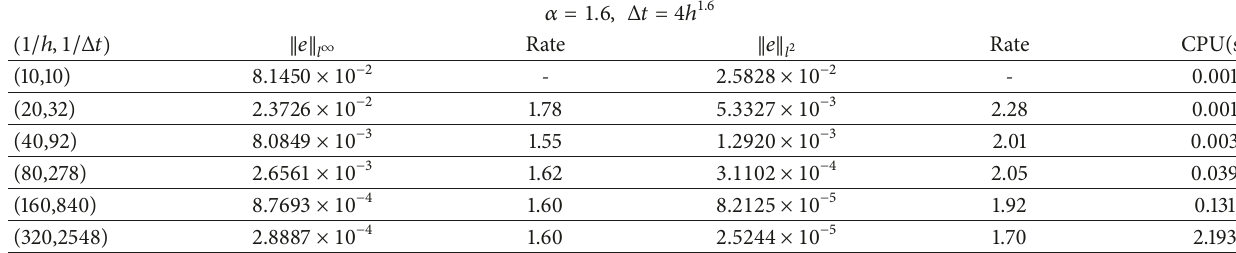
Table 5: Error and convergence rates for Example 2. 𝛼 = 1.6, Δ𝑡 = 4ℎ 1.6